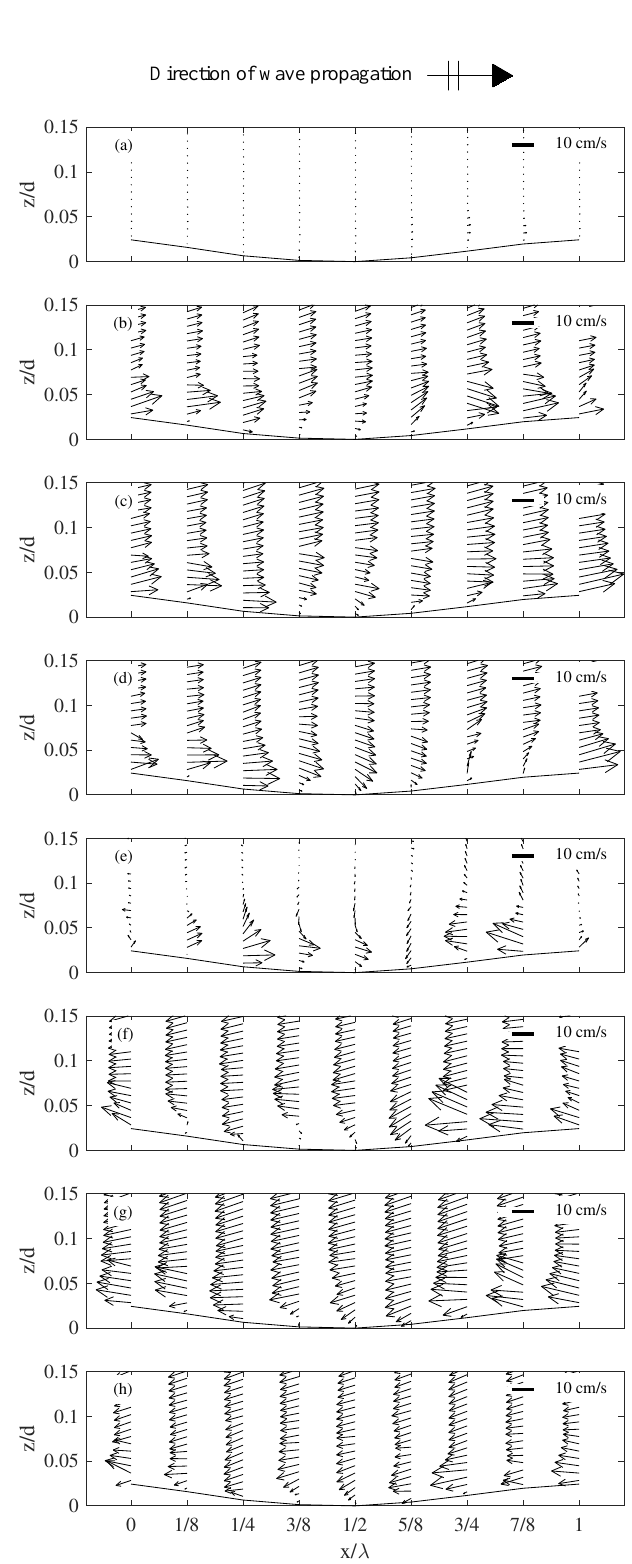
Figure 12. T 9 test ( H = 5.86 m, T = 1.26 s), velocity field along ripple P 1 at eight phases: ( a ) 0; ( b ) 1/4 π ; ( c ) 1/2 π ; ( d ) 3/4 π ; ( e ) π ; ( f ) 5/4 π ; ( g ) 3/2 π ; and ( h ) 7/4 π